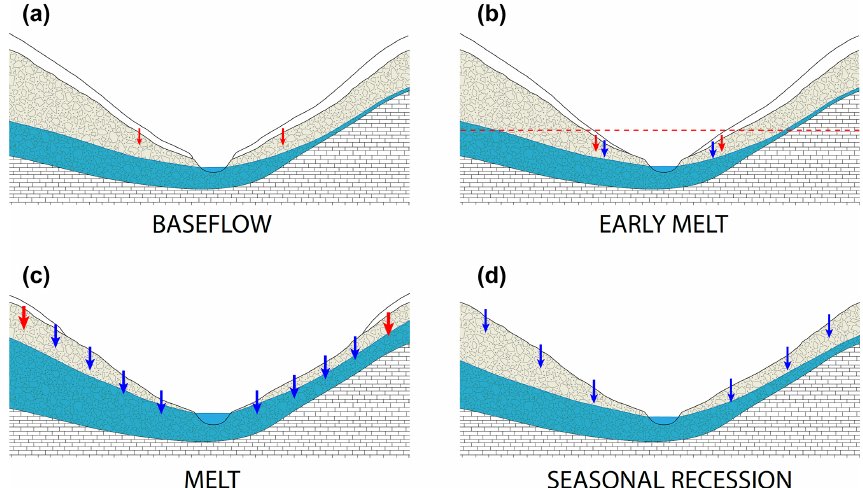
Figure 8. Conceptual figure illustrating the four streamflow generation periods, namely baseflow (a) , early melt (b) , melt (c) , and seasonal recession (d) . Red arrows represent water depleted in heavier isotopes (for example, snowmelt), and blue arrows represent water enriched in heavier isotopes (i.e., rain). Magnitude of flux (size of arrows), location of flux, distribution of saturated area (blue), and snow cover (white) vary between the four seasons. The descriptions of the panels are given in the following sentences (from left to right and top to bottom). The baseflow shows a minimal contribution of snowmelt to subsurface and surface, even during winter. During early melt, the snow recedes at the lower elevations first (dashed red line) and contributes to streamflow. The melt period is characterized by retreating snow cover, fluxes dominated by rain input, and small snow contributions at high elevation. Finally, seasonal recession consists only of rain inputs. Asymmetric hillslopes with differing reservoir sizes and hydraulic conductivities may produce different responses during the different